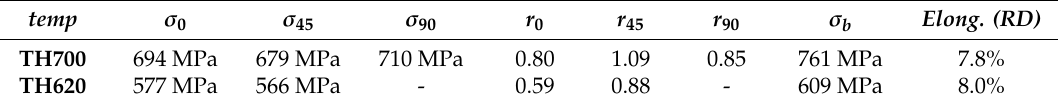
Table 3. Assessed parameters for selected materials.